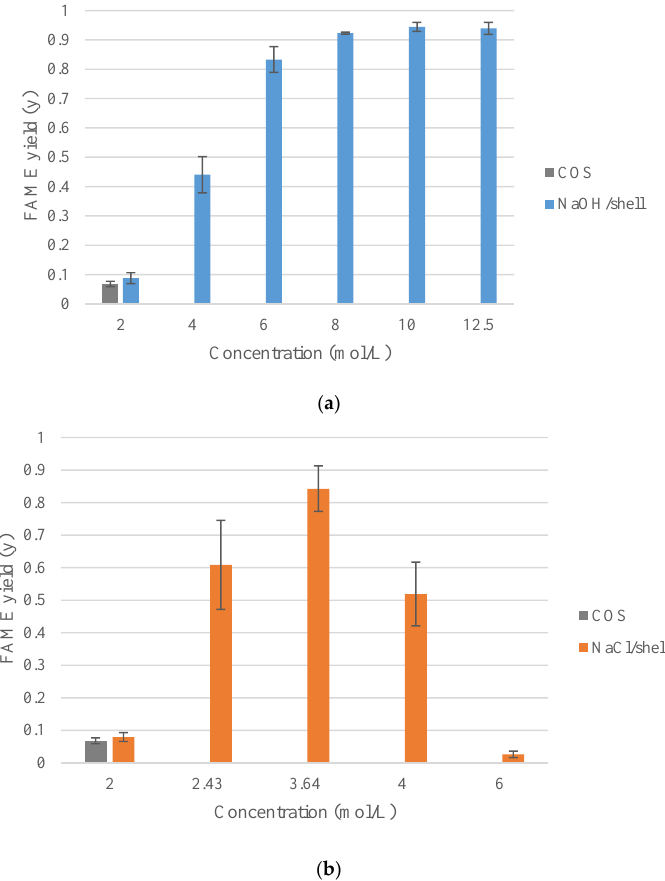
Figure 1. The FAME yield of the transesterification reaction catalyzed by various concentrations of NaOH ( a ) and NaCl ( b ) impregnated calcined oyster shell. Transesterification conditions: temperature = 62 ◦ C; stirring rate = 800 rpm; MR = 12; CL =